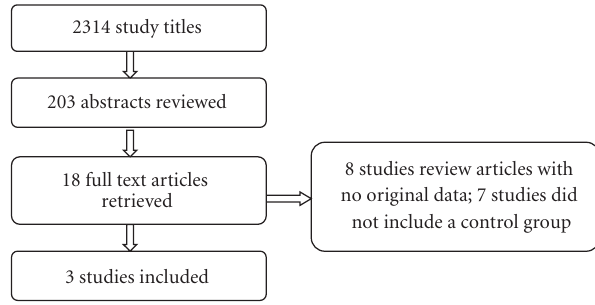
Figure 1: Screening of studies for inclusion in